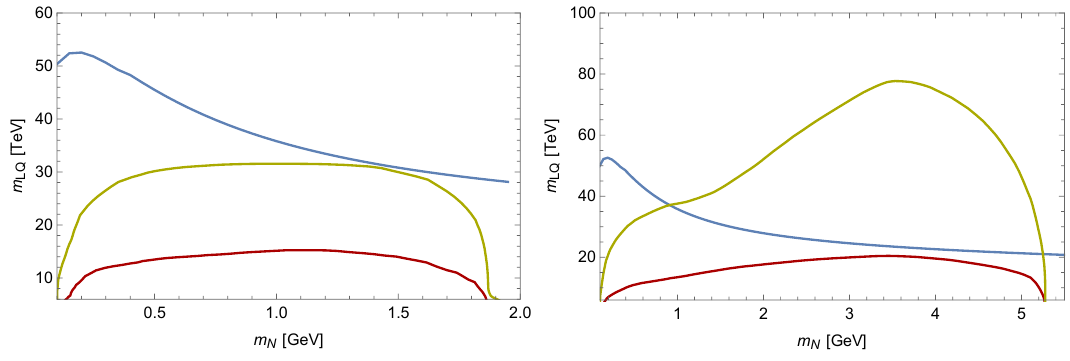
Figure 12 . Comparison between constraints from neutrinoless double beta decay of 136 Xe (blue) [114] and projected sensitivity of FASER2 (red) and MATHUSLA (yellow) for the leptoquark scenario. In the left (right) panel we turned on LQ couplings corresponding to (cid:13)avor benchmark 1 (3). See text for more